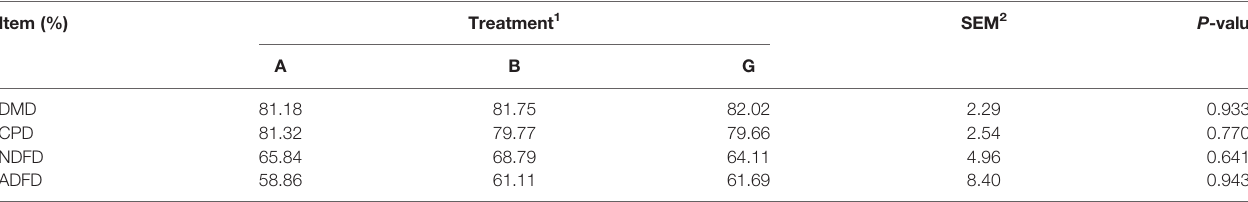
TABLE 2 | Disappearance rate of nutrients affected by dietary non-protein nitrogen